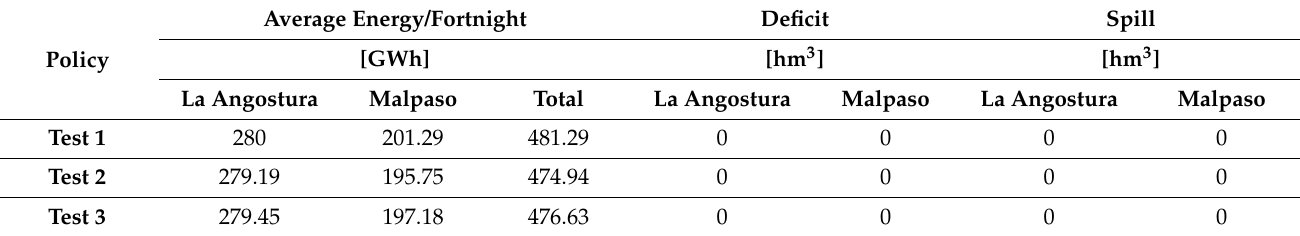
Table 3. Results of policies tested: energy, deficit, and spillover.